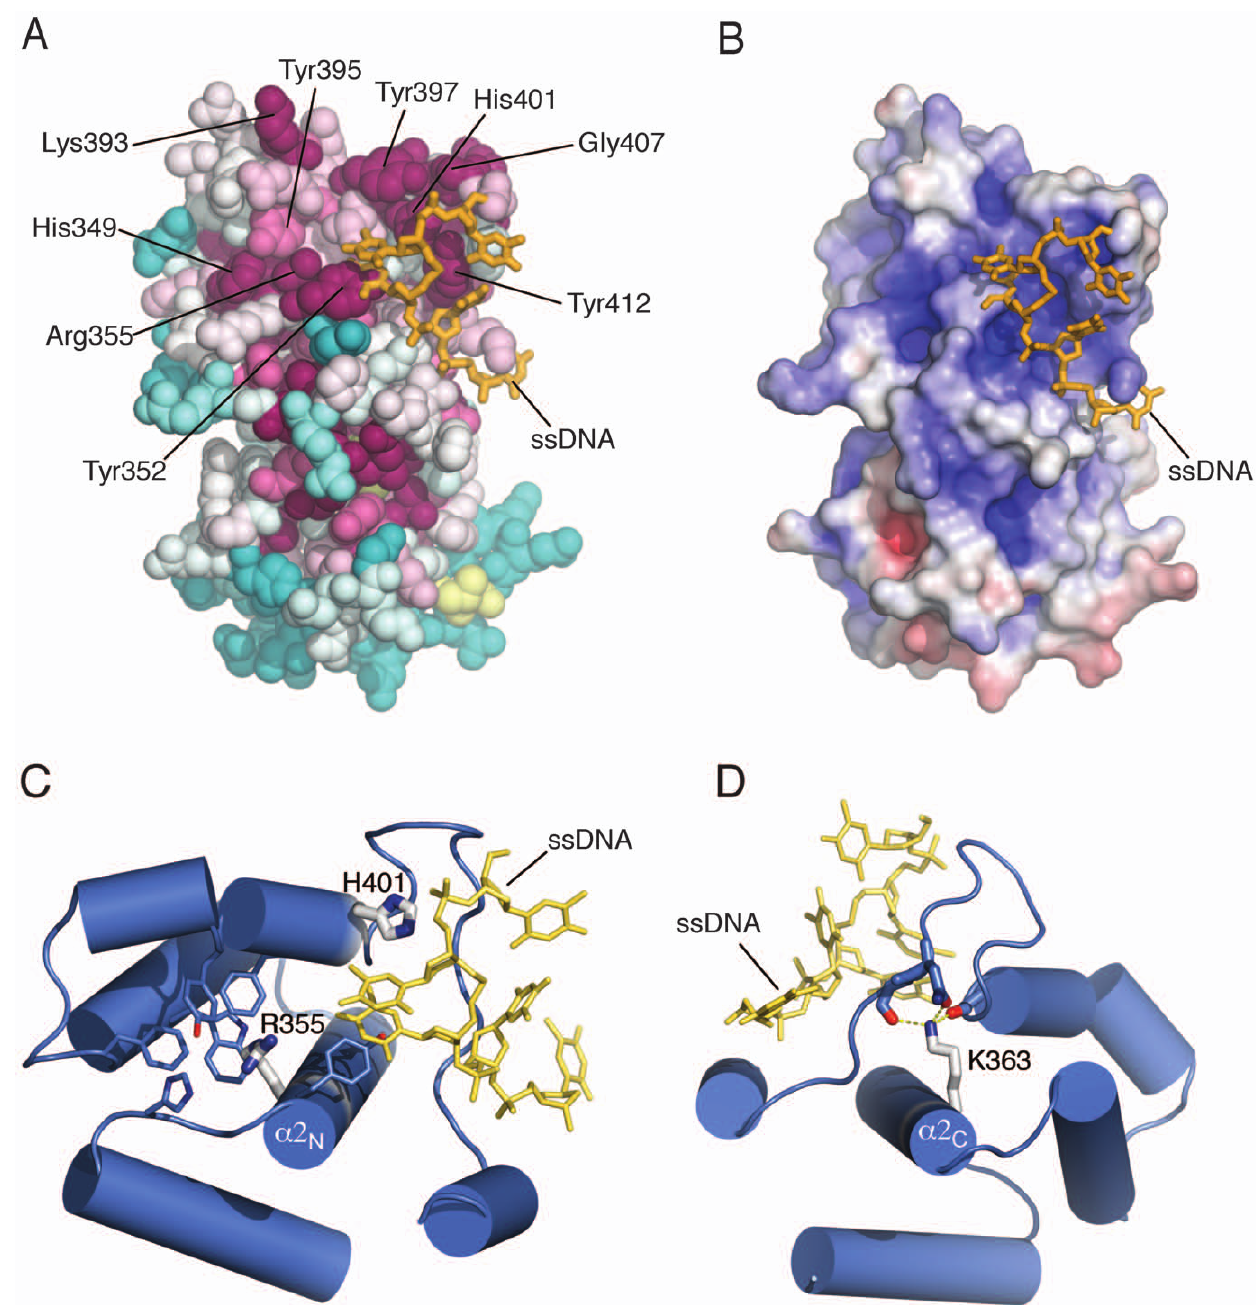
Figure 3. Structural features of the yeast PriL-CTD. ( A ) Amino acid conservation mapped on the crystal structure of the PriL-CTD. The evolutionary conservation analysis of surface residues was performed with the ConSurf server [28], based on 49 sequences of eukaryotic primases. Degree of conservation is shown by colour range, from magenta (highest conservation) to cyan (lowest). The structure is shown in space fill representation. Highly conserved residues that might be important for the functional role of the PriL-CTD are indicated. The ssDNA molecule of the DASH cryptochrome 3 co-crystal (PDB id: 2VTB), superimposed on the PriL-CTD, is shown in stick representation. ( B ) Electrostatic potential of the PriL- CTD, mapped on its solvent-accessible surface at contouring levels of 6 5 kT. Positive charge is in blue, negative charge in red. The potential was calculated using APBS [29] in PyMol (http://www.pymol.org/). The ssDNA is depicted as in panel B. ( C ) and ( D ) Structural details of PriL-CTD residues known to have important functional roles in primase function. Panel C depicts Arg 355 and His 401, panel D shows Lys 363. Please see text for the functional interpretation of their role. The side chains are shown as thick or thin sticks, the helices as cylinders. The ssDNA from the cryptochrome 3 co-crystal structure is also shown in yellow. Polar interactions involving Lys 363 are drawn as dashed yellow lines.